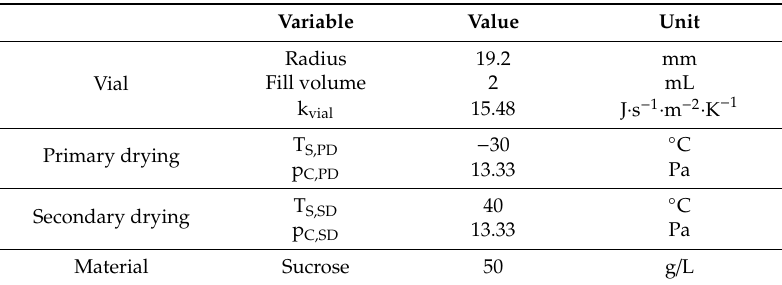
Table 2. Input data for model verification from literature [59].